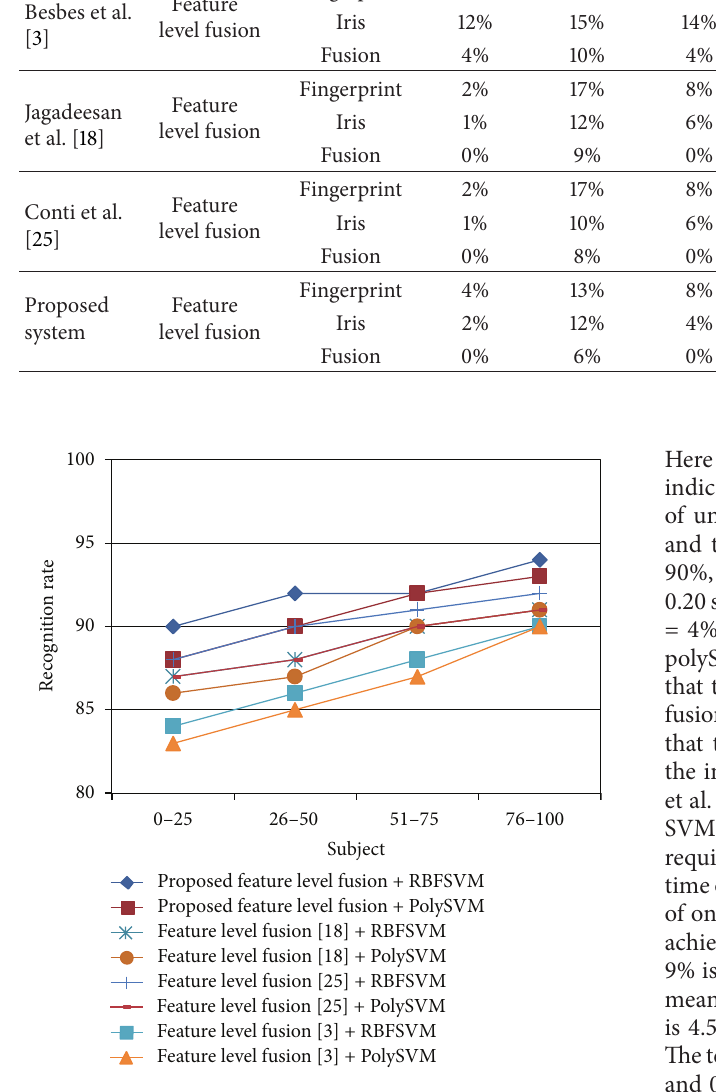
Figure 6: Comparison of recognition